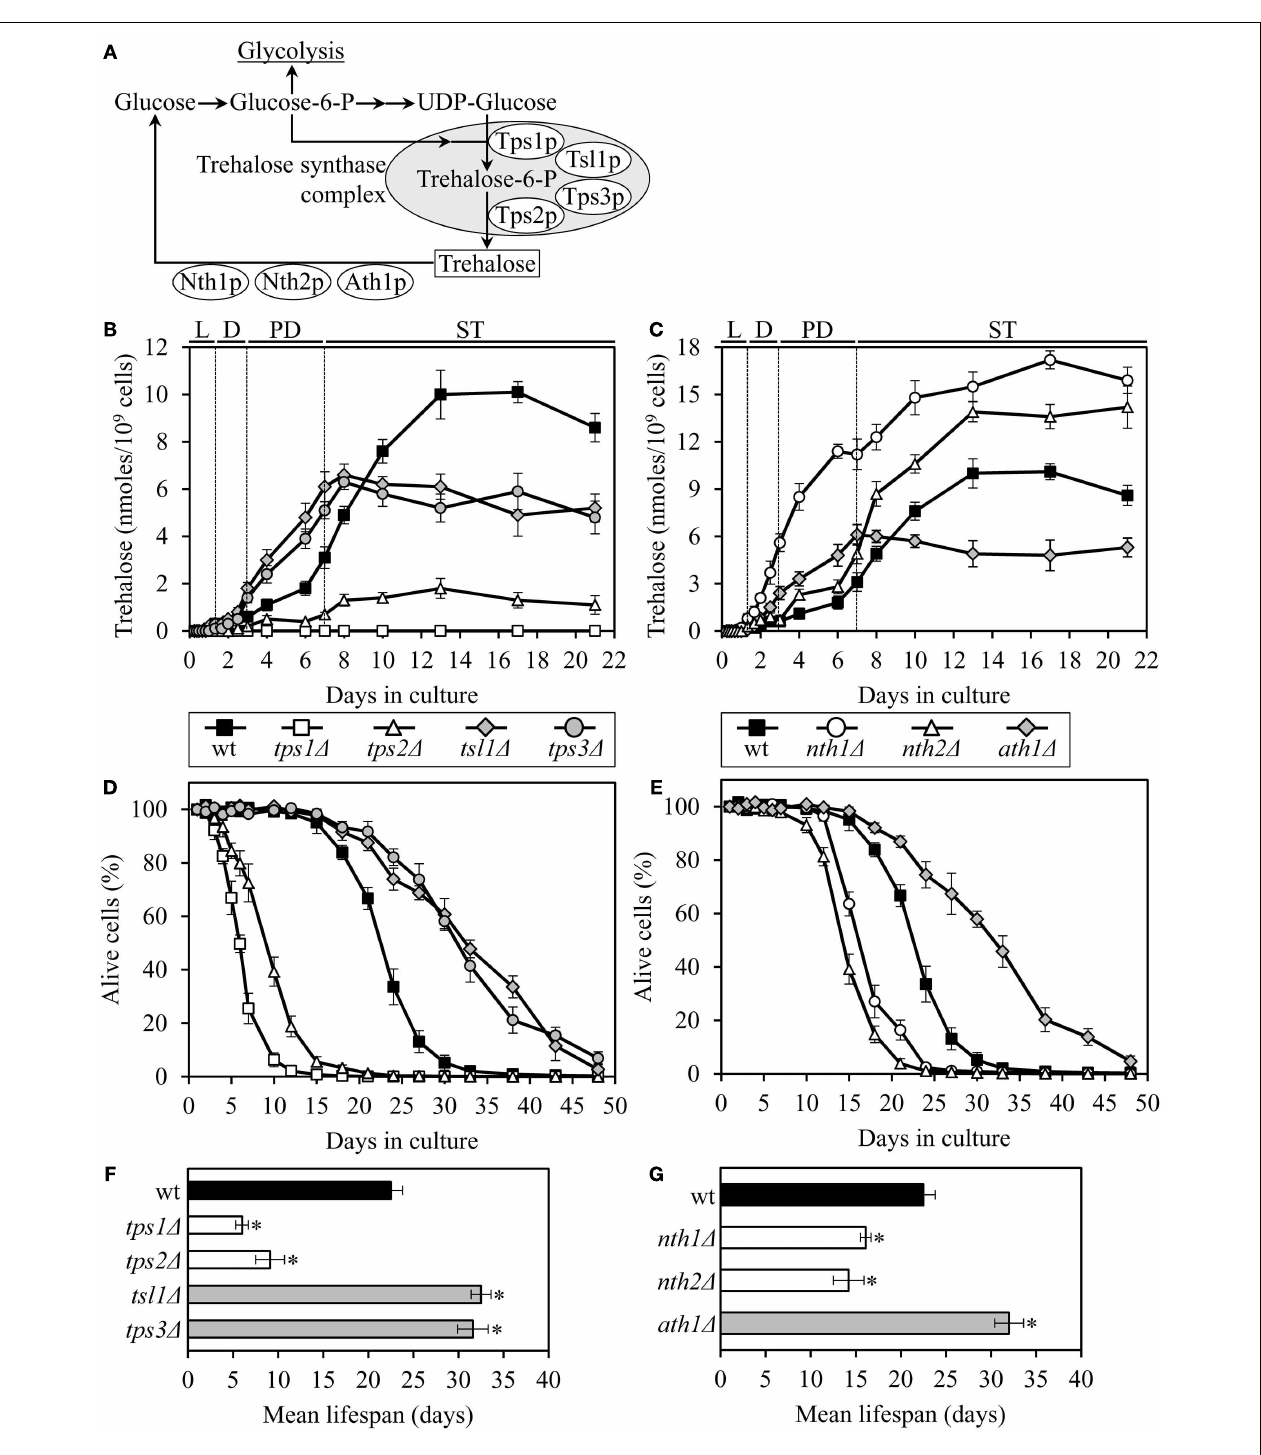
FIGURE 1 |The chronological lifespan of yeast grown under CR conditions can be extended by mutations that simultaneously increase trehalose concentration prior to quiescence and reduce trehalose concentration following entry into a quiescent state. (A) Outline of metabolic pathways of trehalose biosynthesis and degradation. (B,C) The dynamics of age-dependent changes in the intracellular levels of trehalose during chronological aging of wild-type (wt) and mutant strains. (D–G) Survival